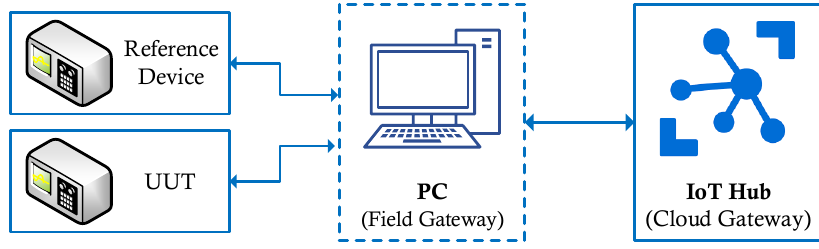
Figure 8. A simple calibration setup connected to the cloud through a field